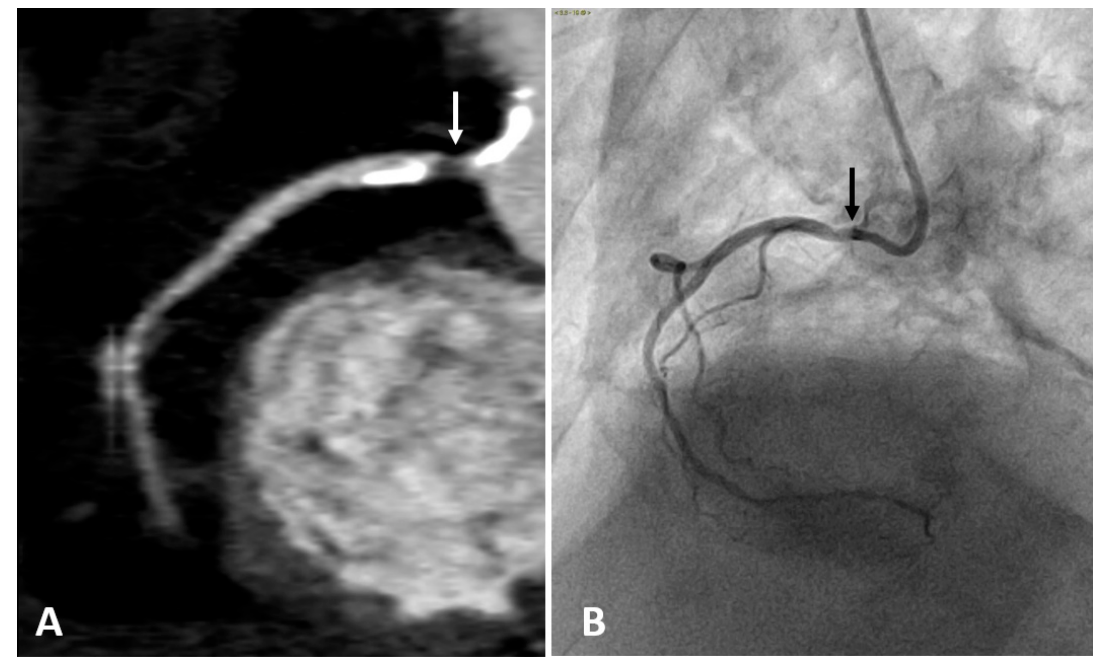
Figure 2. Right coronary artery (RCA) studied with CTCA ( A ) and with coronary angiography ( B ) in the same patient. Both examinations show a narrowing of the arterial lumen in the proximal RCA segment (arrows), indicating the presence of an atherosclerotic plaque. CTCA imaging shows a low-attenuation non-calcified plaque which identifies a lipid or necrotic core. Calcifications are hyperdense on CTCA, while not visible on coronary angiography.